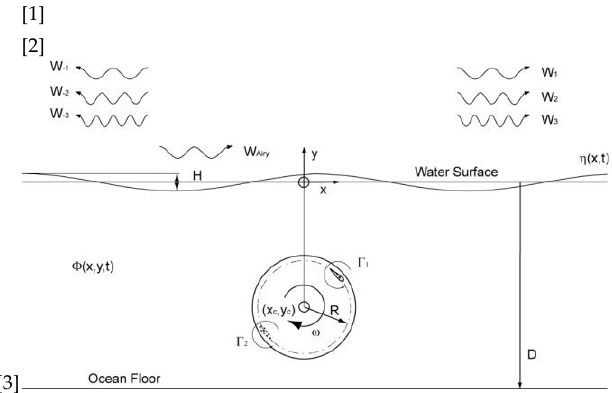
Figure 1: Representation of the CycWEC geometry [12].